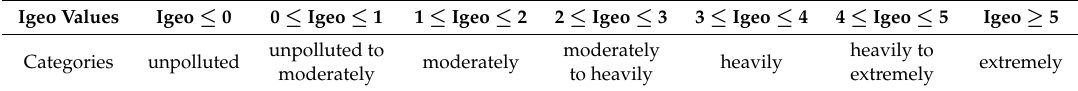
Table 2. Contamination categories on the basis of Igeo